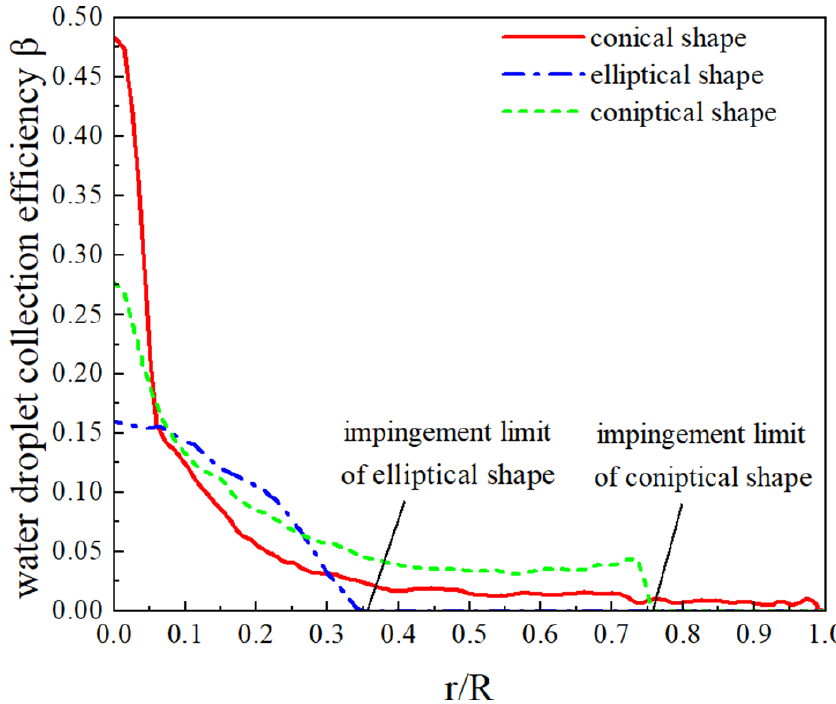
Figure 5. Variation of the water droplet collection coefficient of the three